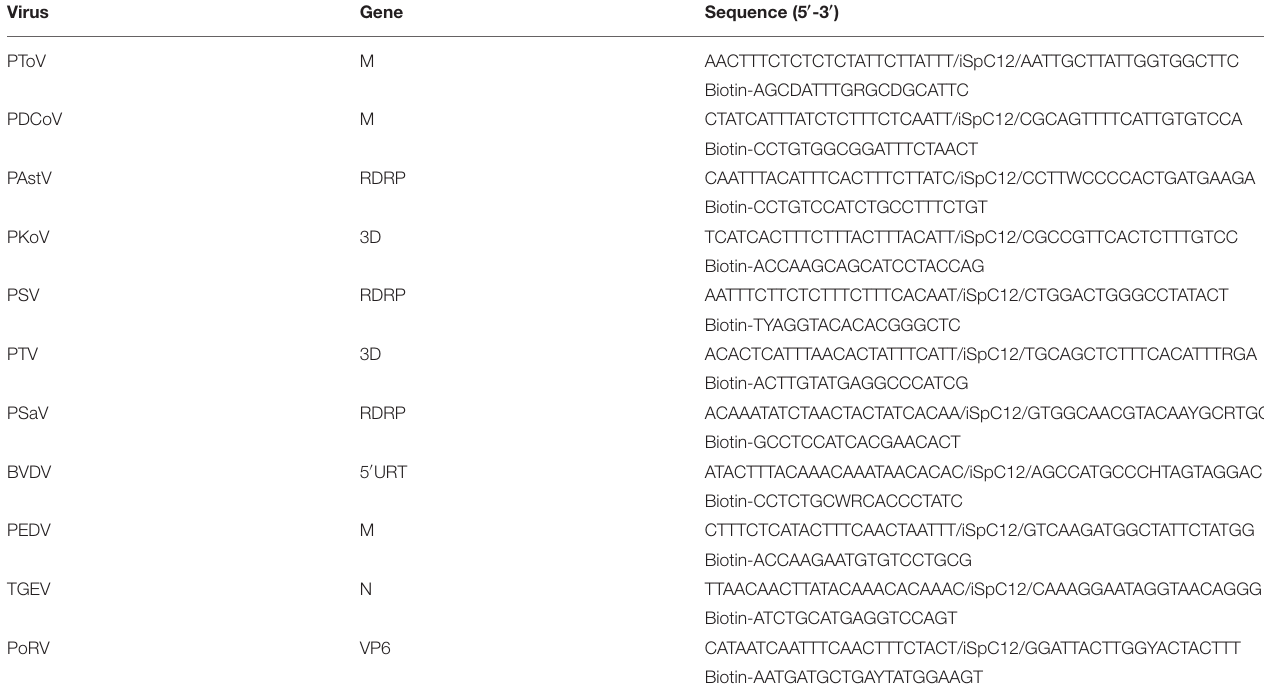
TABLE 2 | The PCR primer pairs of 11 pathogens. Virus Gene Sequence (5 ′ -3 ′